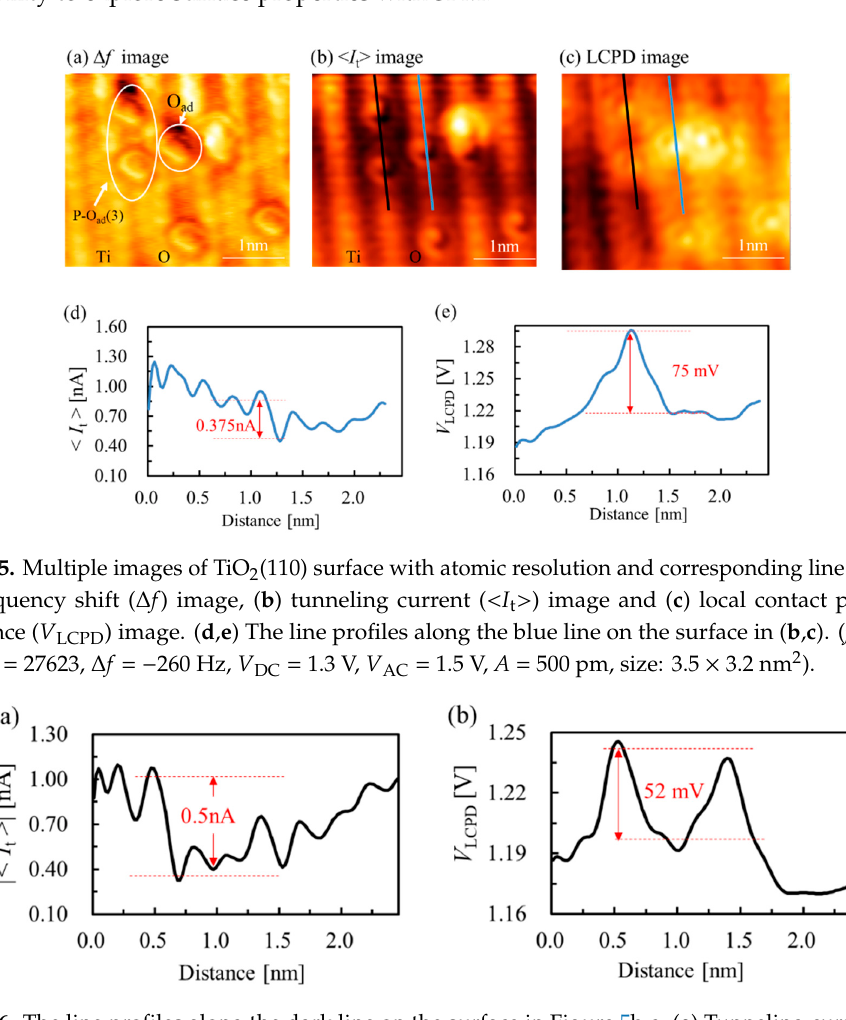
Figure 6. The line profiles along the dark line on the surface in Figure 5b,c. ( a ) Tunneling current and ( b ) local contact potential difference line profiles along the paired O adatoms.